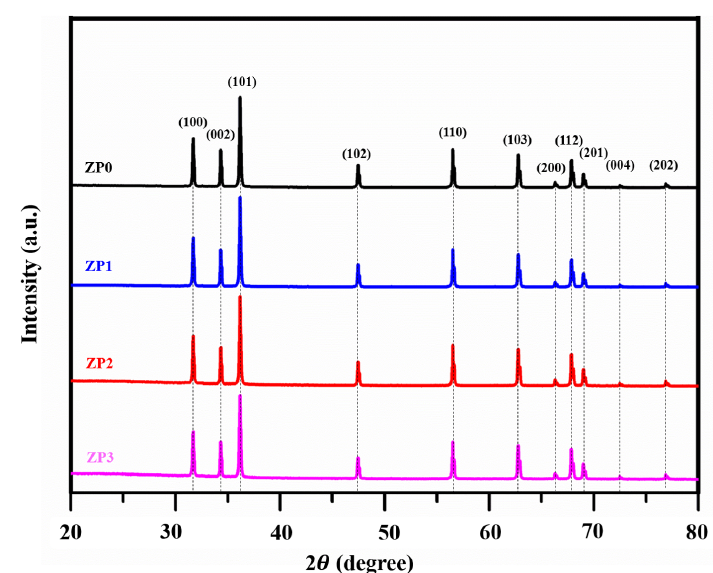
Figure 2. XRD patterns of ZnO and functionalized ZnO